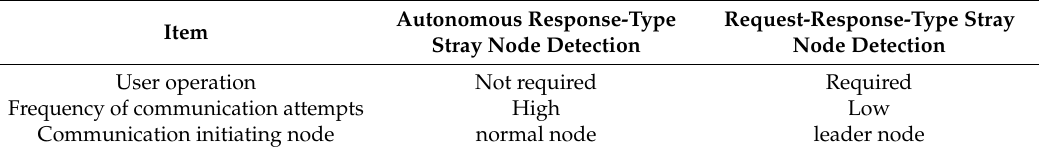
Table 1. Characteristics of the autonomous response-type and the request-response-type protocols.